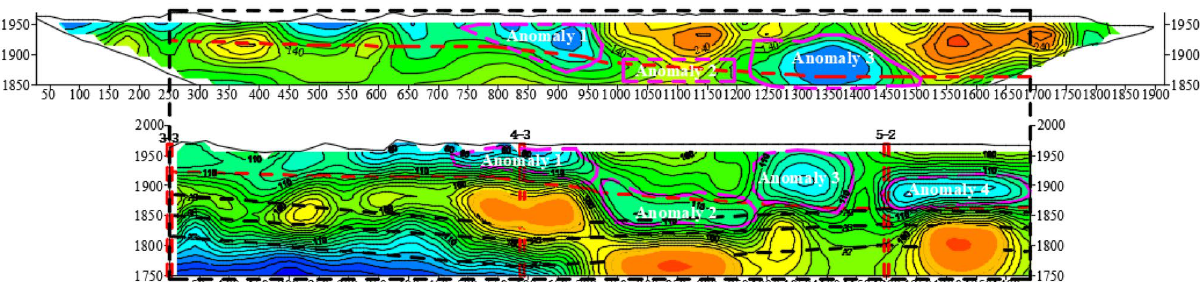
Figure 22. Comparison of resistivity profile of the TEM of 140 m mileage cross-section and HDRM of